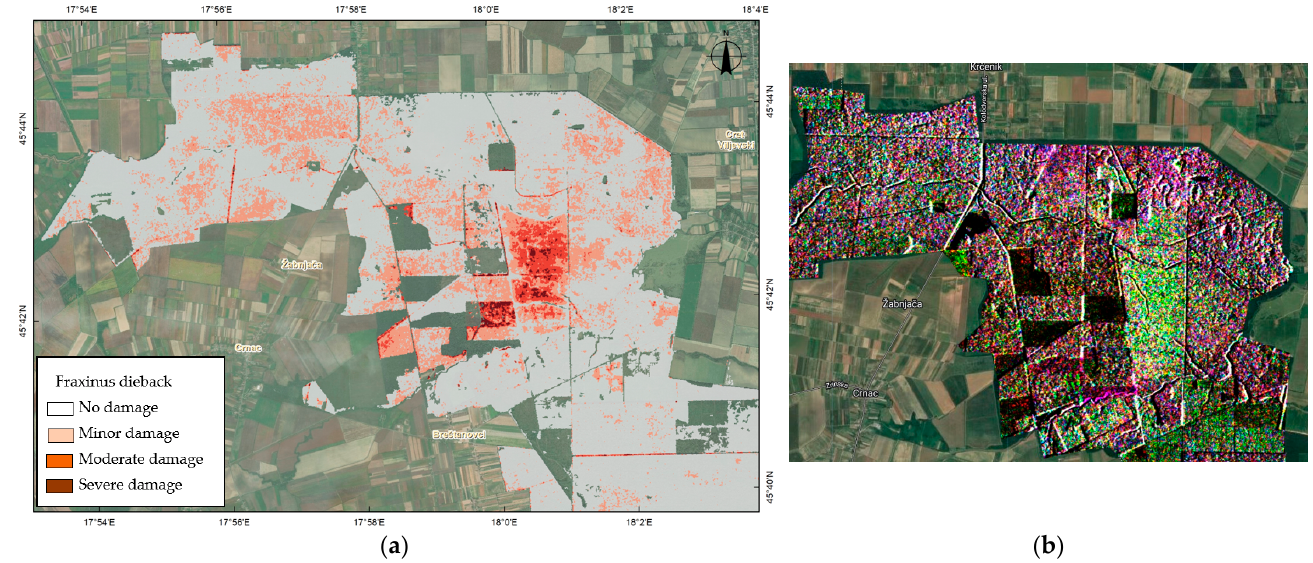
Figure 5. ( a ) Map of ash damage status due to Hymenoscyphus fraxineus dieback in 2019. Natura 2000 floodplain Fraxinus angustifolia forest, near Donji Miholjac, Croatia, and ( b ) segment of the area showing ash dieback detected by SAR, Sentinel-1 backscattering colour composite (period 1 June–31 July 2019) (source: MySustainableForest, https://mysustainableforest.com/, accessed on 10 January 2023).